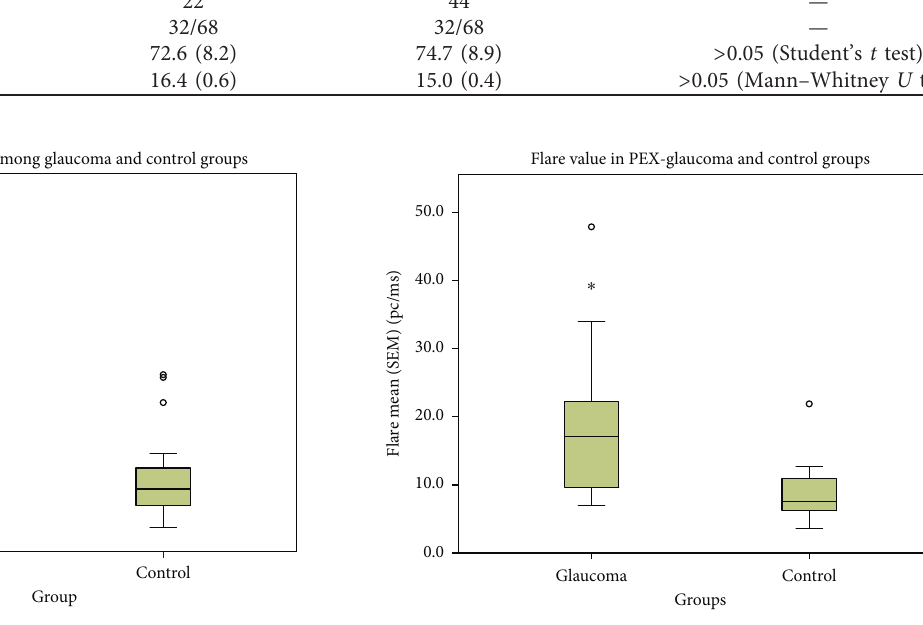
Figure 3: Flare value among PEX-control and glaucoma groups. The glaucoma group showed significantly higher aqueous humour flare mean values than the control group. Ocular surface’s sub- jective and objective evaluation.